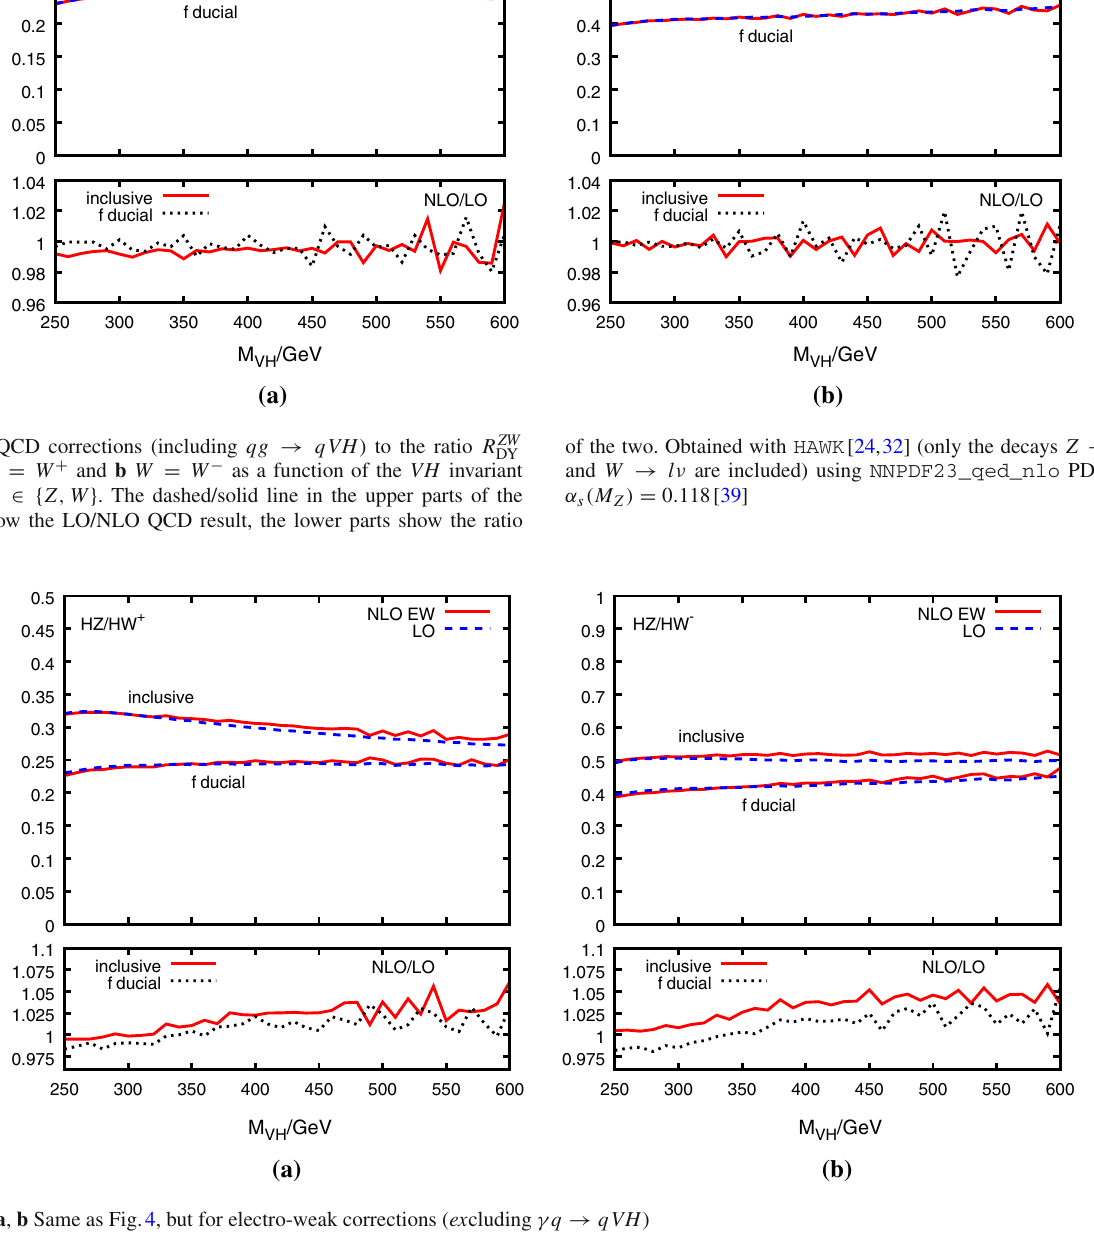
weak effects on R ZW show a stronger dependence on M VH , DY albeit in a very continuous and monotonous